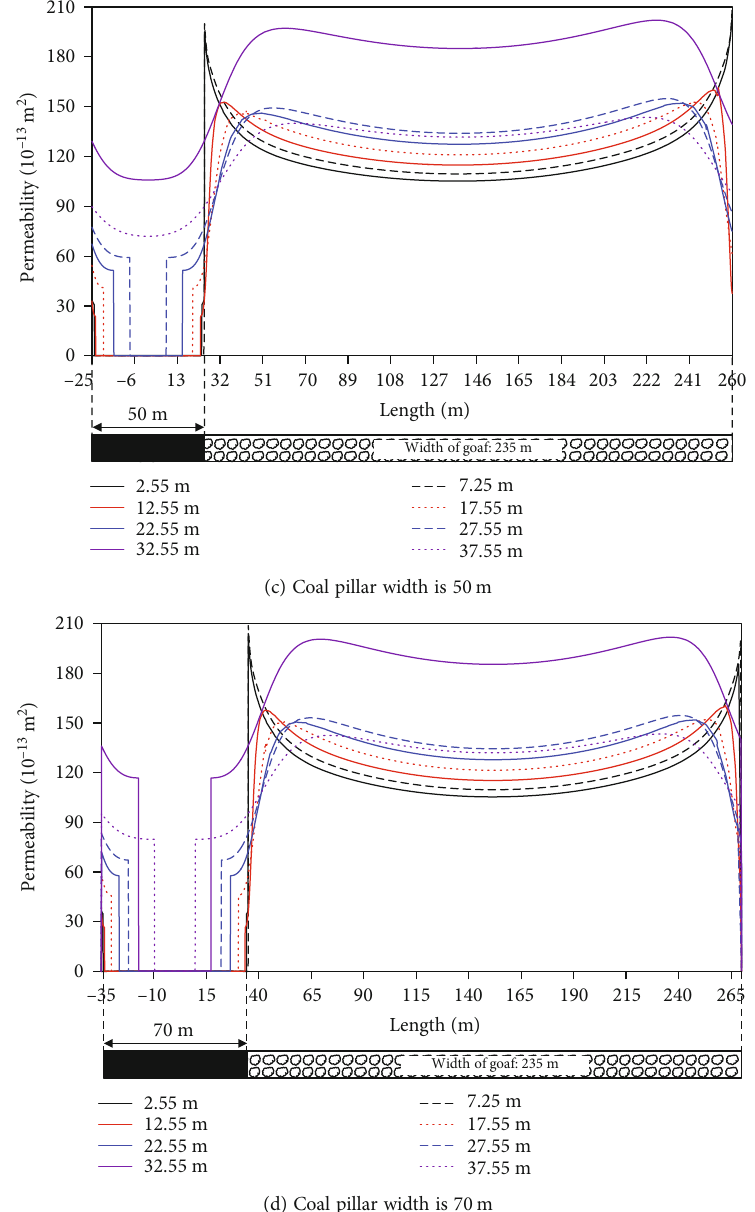
Figure 6: Permeability distribution curves at di ff erent coal pillar widths. (a) Coal pillar width is 10m. (b) Coal pillar width is 30 m. (c) Coal pillar width is 50m. (d) Coal pillar width is